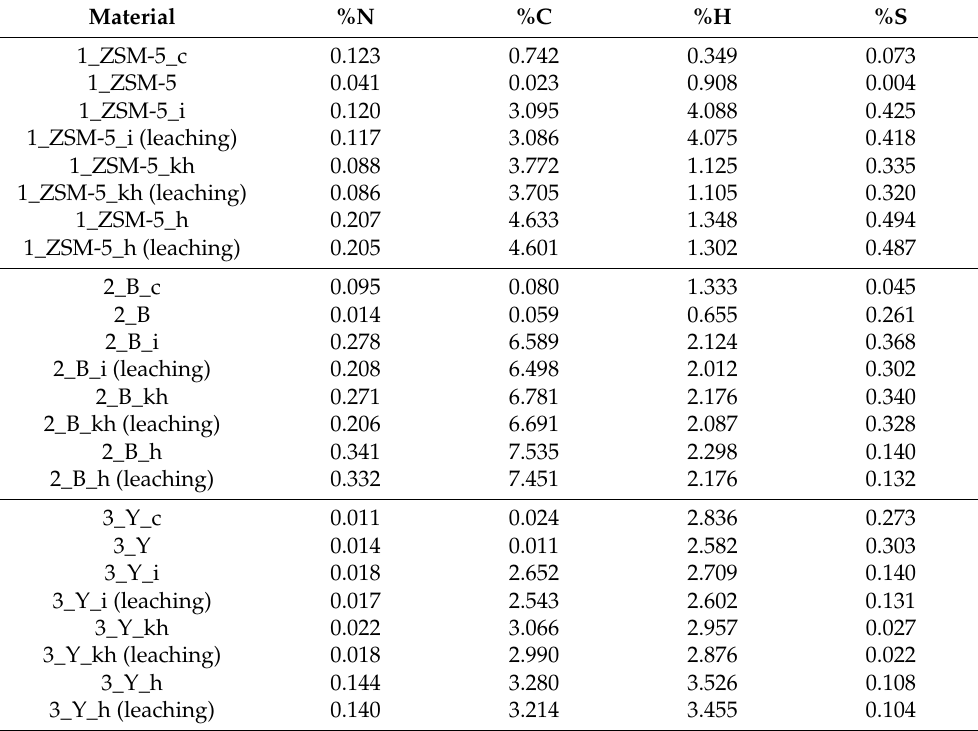
Table 2. Elemental analysis of hierarchical materials obtained from zeolites of MFI (ZSM-5), BEA ( β ), and FAU (Y)